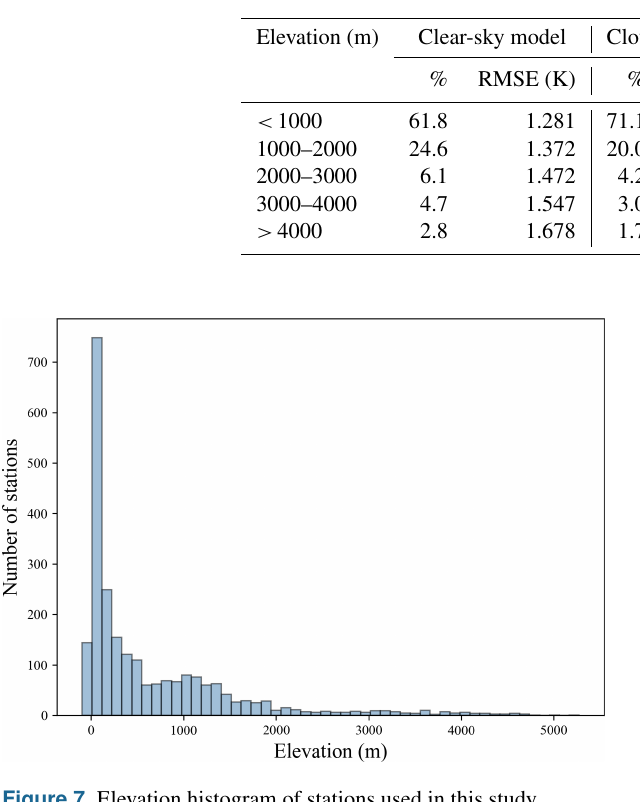
Table 4. Model performance for different elevation ranges.